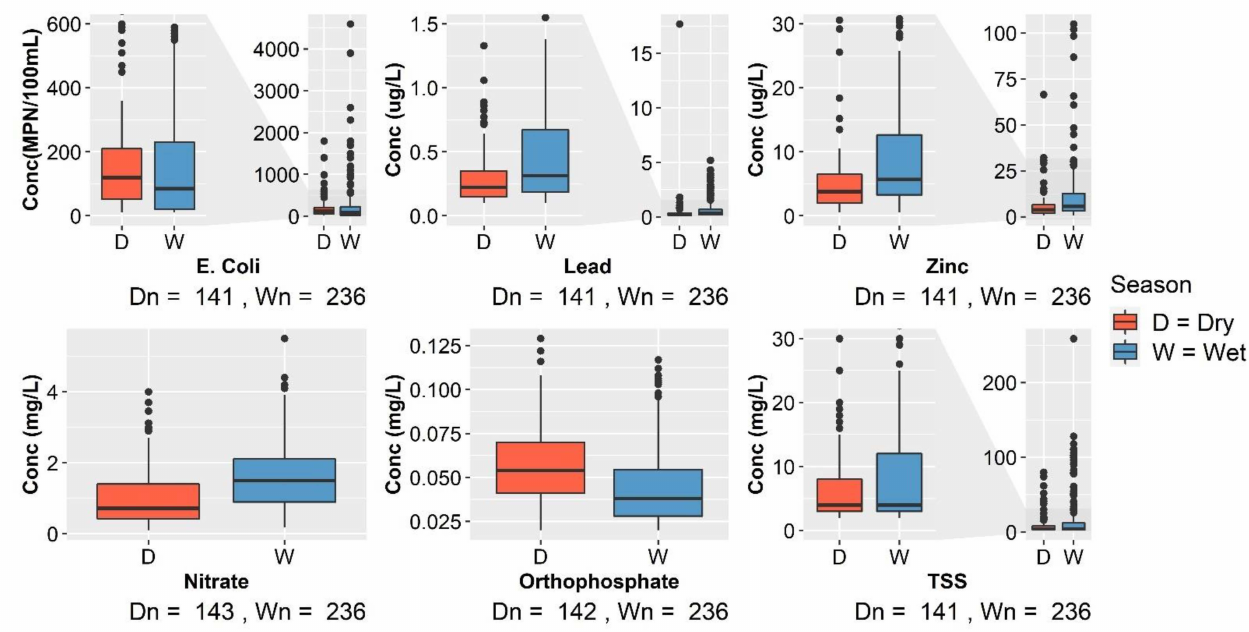
Figure 2. Boxplots showing the seasonal distributions of E. Coli , lead, zinc, nitrate, orthophosphate, and TSS concentration from 36 eligible